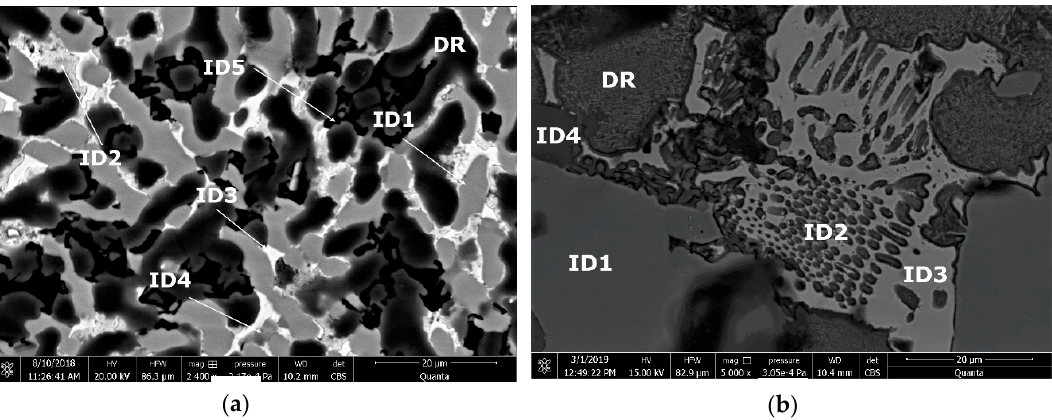
Figure 13. Optical micrographs of ( a ) as-cast and ( b ) annealed cast Al 3 Mn 0.2 Zn 0.3 Mg 0.7 Si 0.8 alloy. DR— Figure 14. SEM images of ( a ) as-cast and ( b ) annealed cast Al 3.4 Cu 0.5 Si 0.2 Zn 0.5 Mg 0.2 alloy. DR—dendritic dendritic area; ID—interdendritic area. area; ID—interdendritic area; ID1,2,3, and 4—interdendritic phases (Table 4).